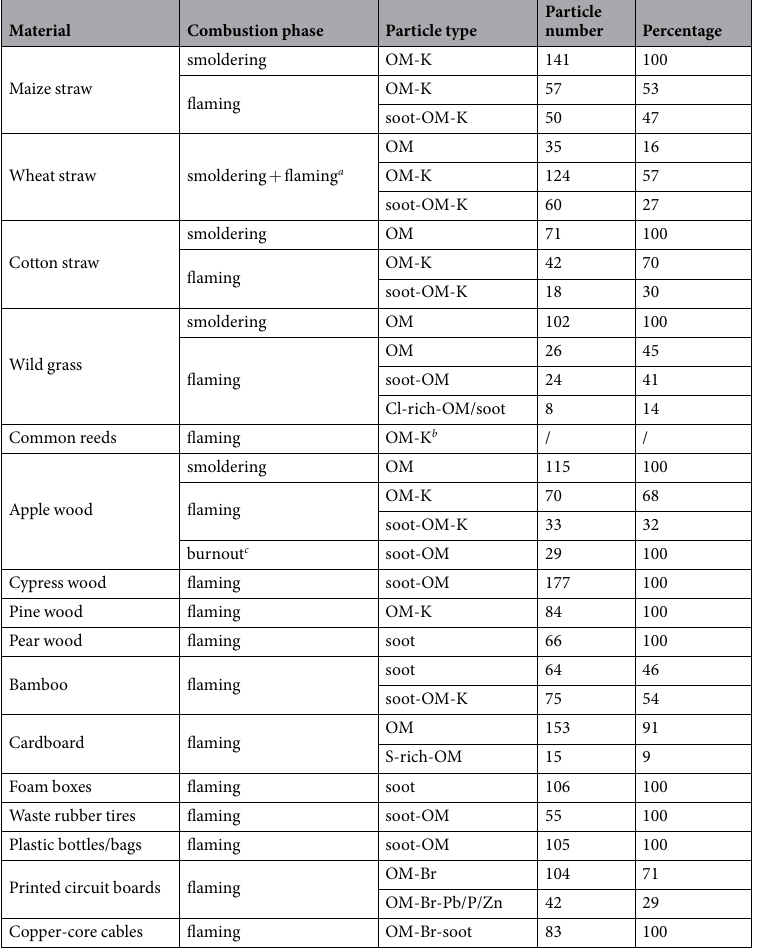
Table 1. Particle classification, analyzed particle number and percentage from different materials in smoldering/flaming phase. a The combustion phases were mixed between smoldering and flaming phases, we present smoldering + flaming here. b The particle number of common reeds cannot be counted because the gel- like OM were connected together. c Burnout refers to the end of the flaming